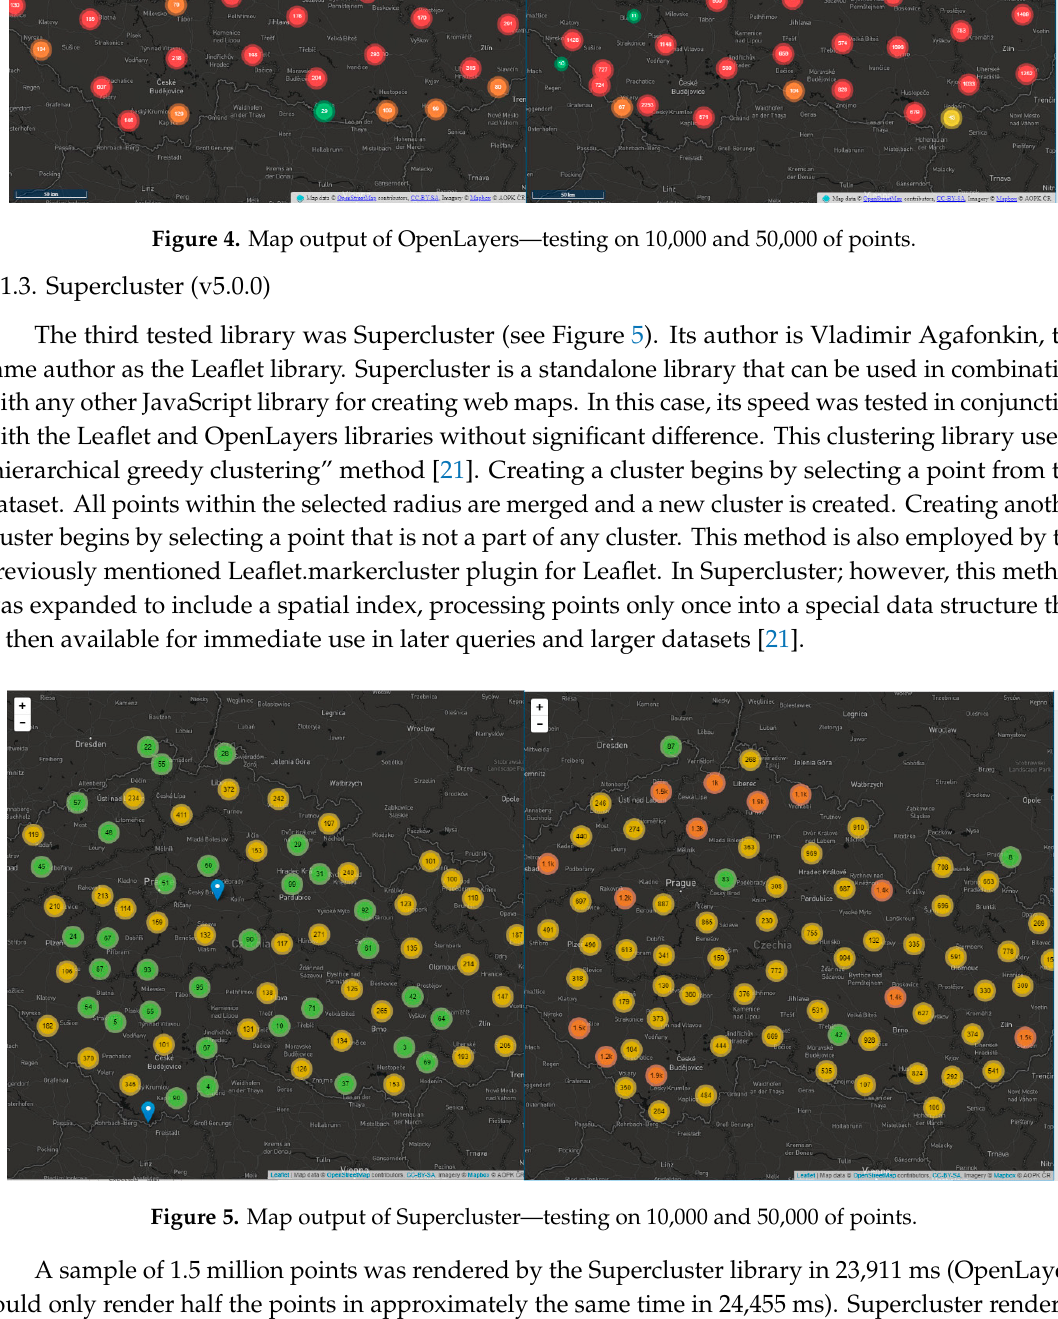
Figure 5. Map output of Supercluster—testing on 10,000 and 50,000 of points. A sample of 1.5 million points was rendered by the Supercluster library in 23,911 ms (OpenLayers could only render half the points in approximately the same time in 24,455 ms). Supercluster rendered the map in 71,776 ms without any problems, even when the entire datasets with more than 3 million points were used. See Table 4 for complete results. The transitions between zoom levels were quick, but definitely did not achieve the fluency of the Mapbox GL JS